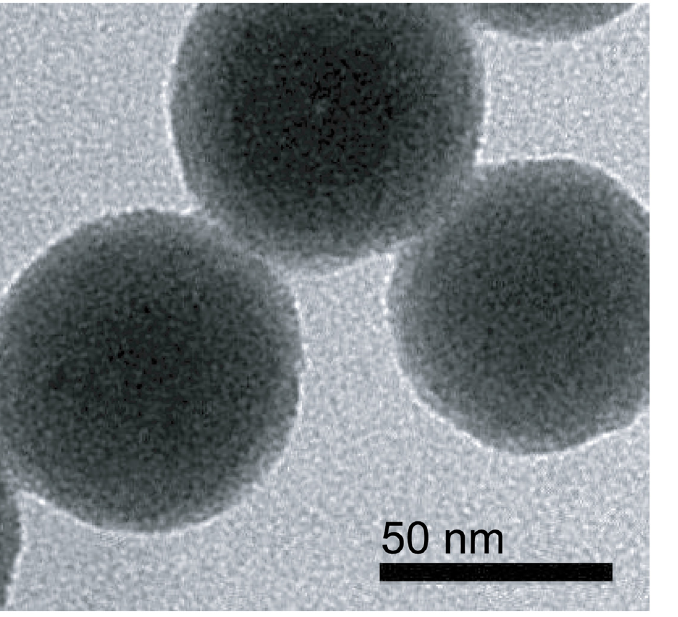
Fig 6. TEM of bare silica nanosphere.